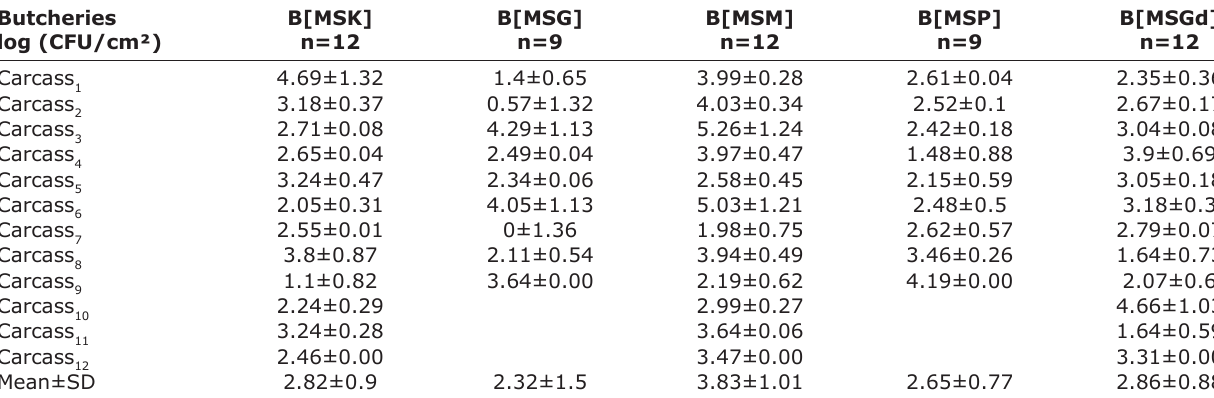
Table-3: Mean of Staphylococcus with positive coagulase in the butcheries. Butcheries log (CFU/cm²)